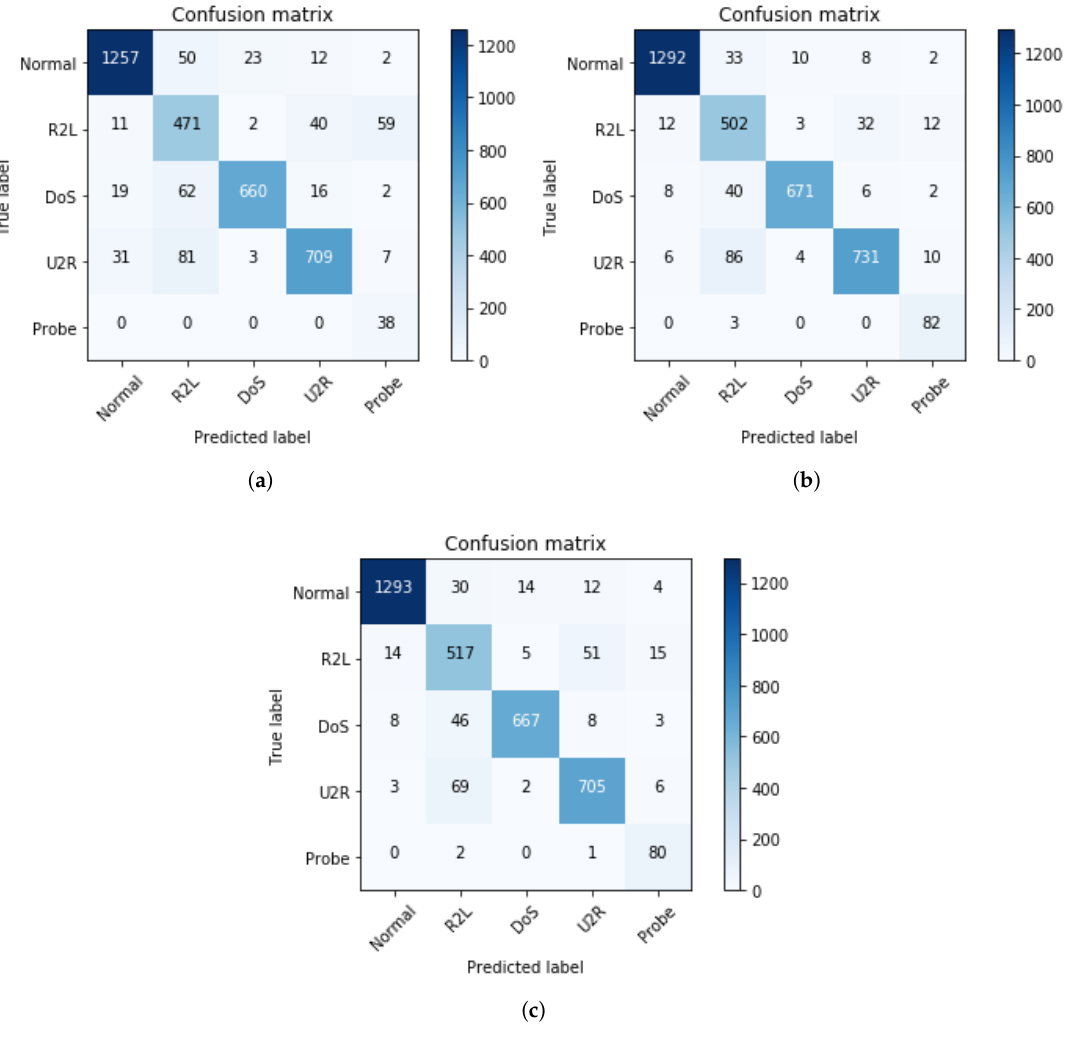
Figure 12. Confusion matrix of three IDS models on NSL-KDD dataset. ( a ) Simple RNN model ( b ) LSTM model ( c ) GRU